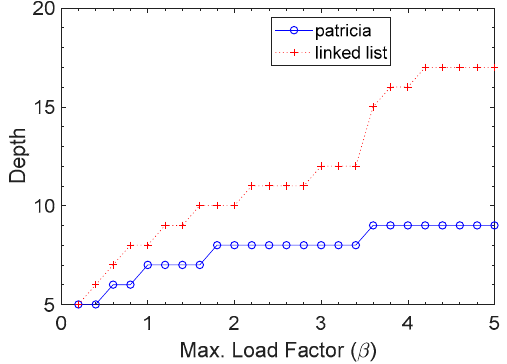
Figure 12. M aximum depth of the Patricia trie and a linked list.